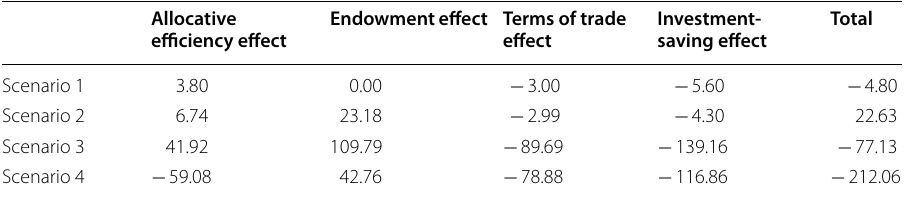
Table 7 Decomposition of the Total Welfare Effect for Ethiopia (US$ millions). Source: Model Simulation